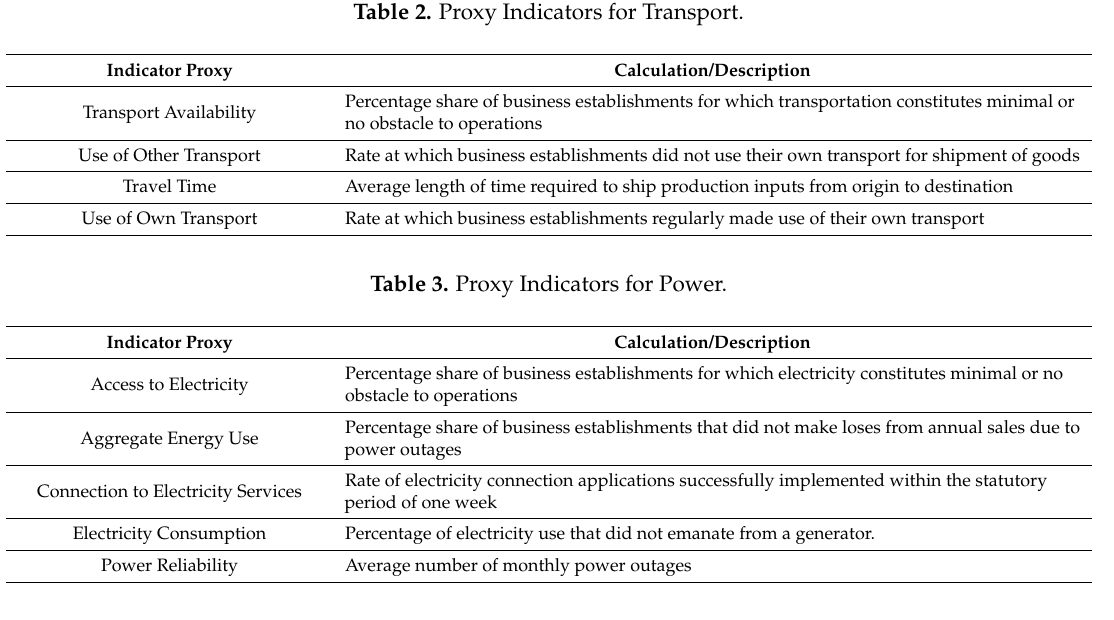
Table 4. Proxy Indicators for Industrial Land.